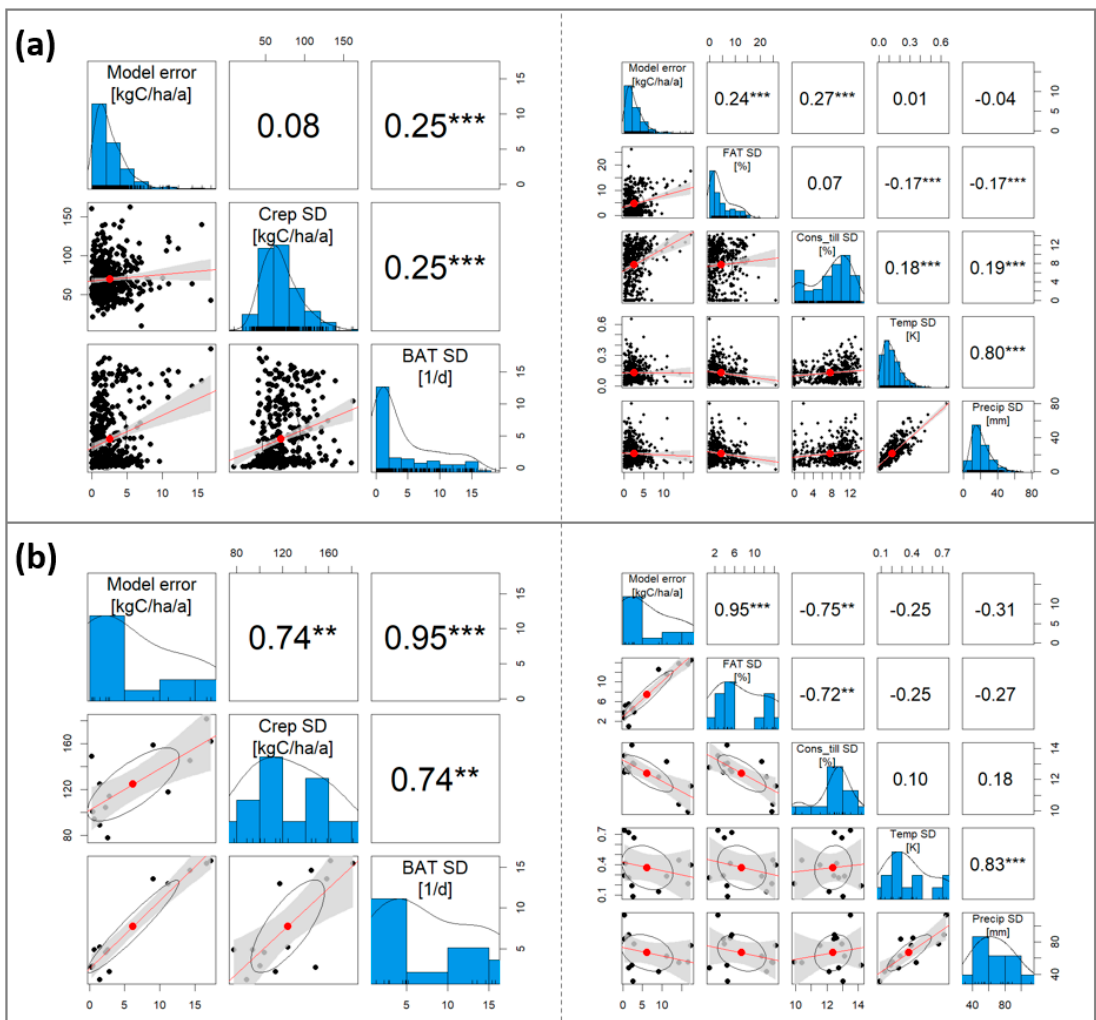
Figure 4. Correlation matrices between absolute errors of the upscaled model set-ups (comparing SOC trends of the upscaled model set-ups with the grid-based reference simulation on the level of individual administrative units) and the spatial dispersion (standard deviation) of a set of predictor variables describing the input and turnover conditions of soil-related carbon. ( a ) Correlation matrices for the LAU-level model set-up; ( b ) Correlation matrices for the NUTS3-level model set-up. The predictors of the matrices are the soil carbon reproduction flux (C rep ), carbon turnover indicator BAT, soil fine particle content (FAT), conservation tillage shares (Cons_till), annual mean temperature (Temp) and annual precipitation (Precip). For each predictor, its regional dispersion (standard deviation—SD) within an administrative unit was calculated from the reference dataset and used for the correlation matrix. The distribution of each variable is shown on the diagonal. Below this diagonal, the bivariate scatter plots with a fitted line are displayed. Above the diagonal, the value of the correlation is shown as well as its significance level (stars), where the p -values of <0.001, <0.01 are associated with the symbols *** and **,